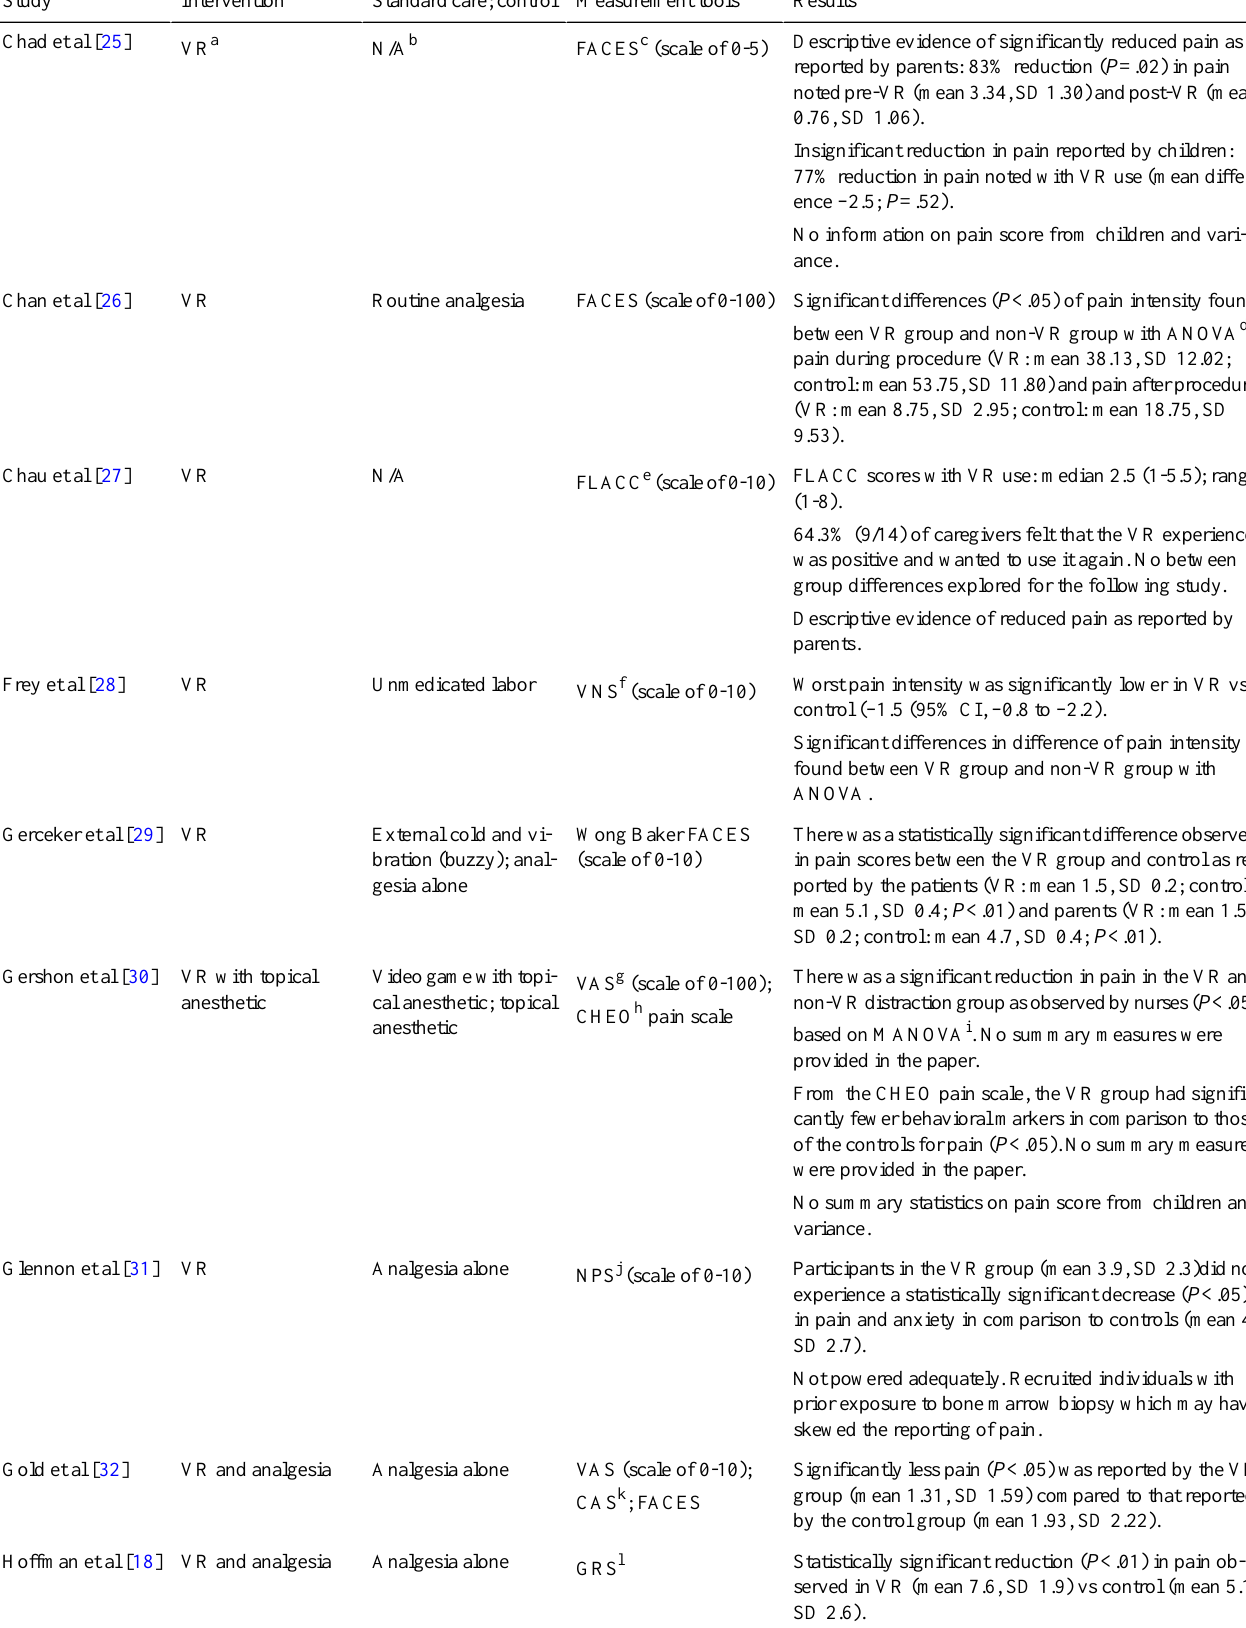
ResultsMeasurement toolsStandard care;